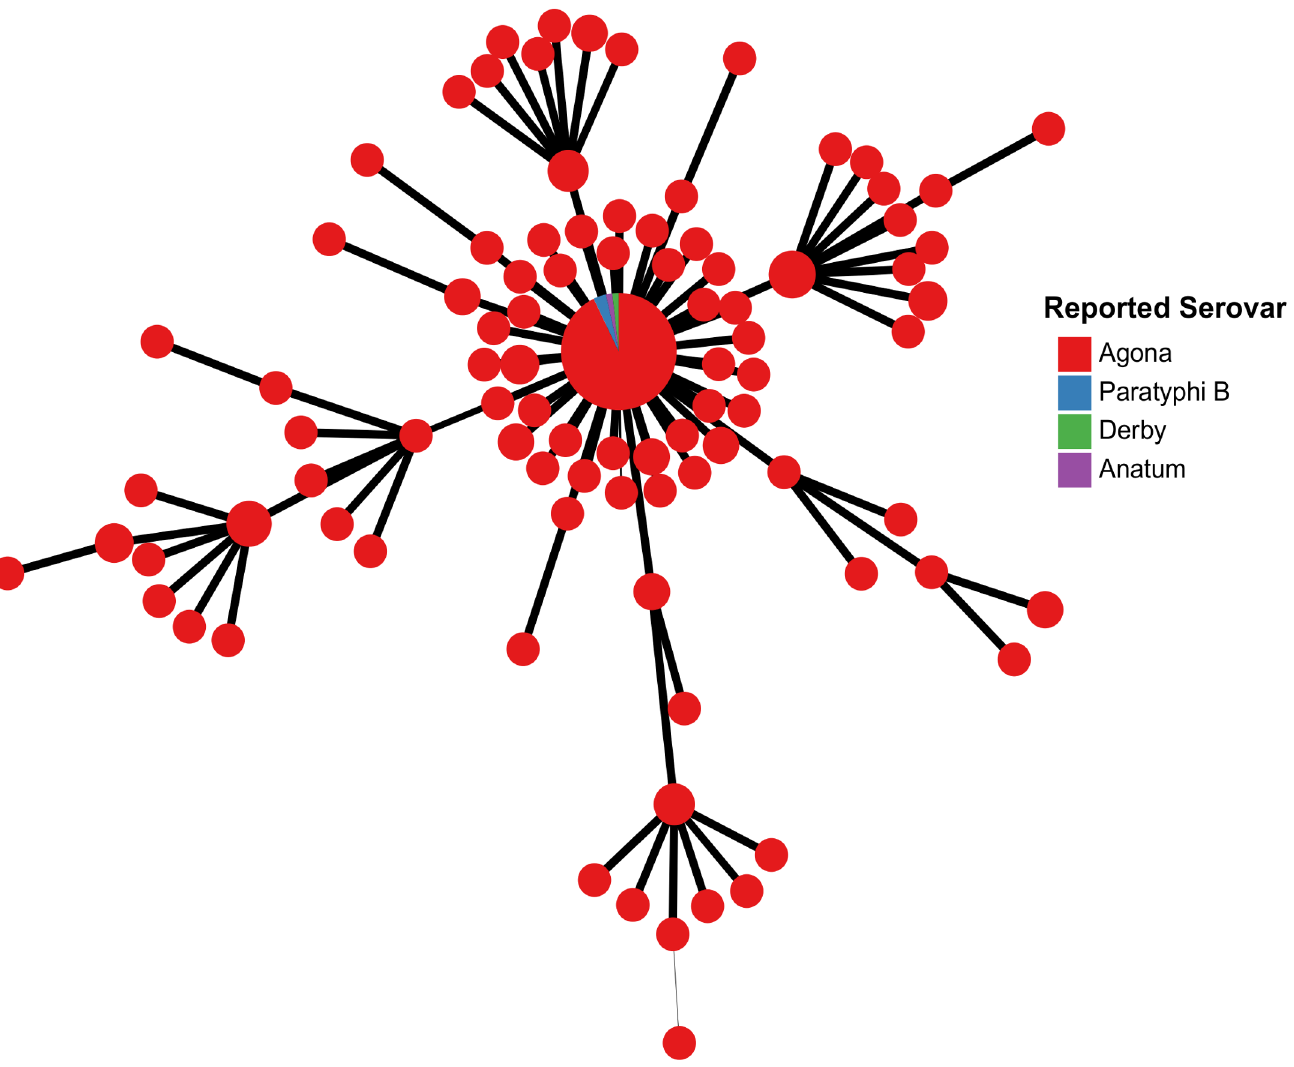
Fig 2. In silico serovar prediction identifies instances of Salmonella genomes with incorrect reported serovar information. Among a large cgMLST330 cluster of genomes of reported serovar Agona were found four genomes of different reported serovar (Paratyphi B, n = 2; Anatum, n = 1; Derby, n = 1). Upon closer inspection, the serovar prediction for these genomes was found to be Agona, consistent with the underlying cgMLST330